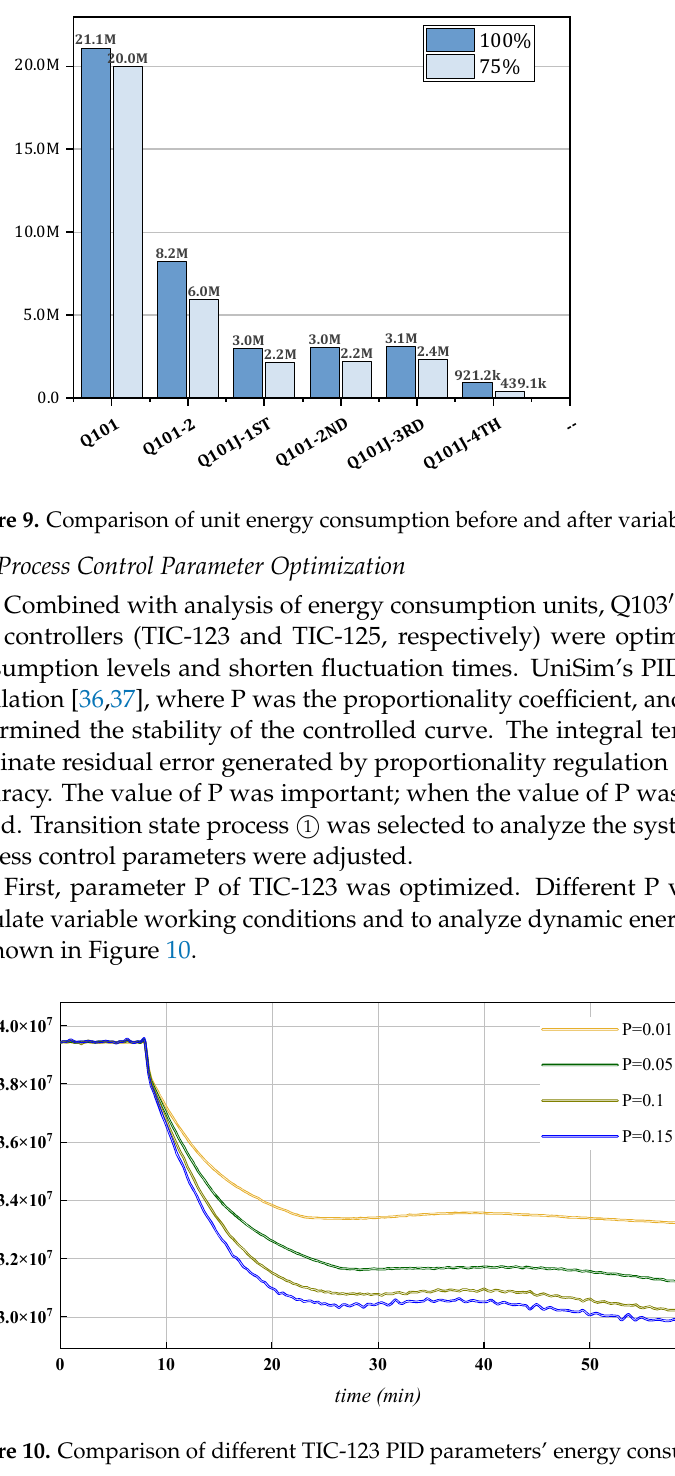
Q 10 1J-2nd, and Q 10 1J-3rd, and the reactor outlet heat exchanger, Q103, had similar energy consumption variation ranges. Q103 and Q103-2 were the key optimization objectives.